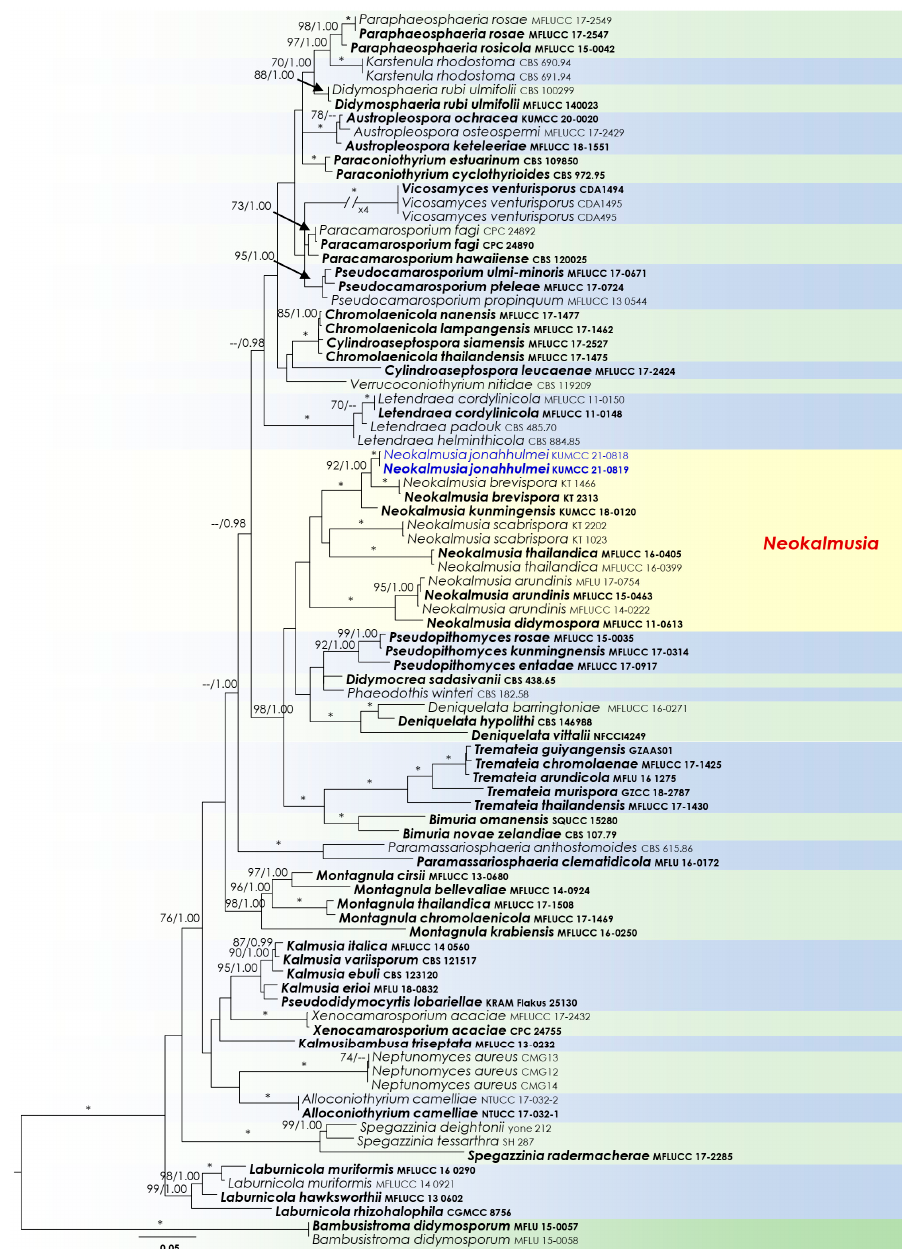
Figure 2. RAxML phylogram generated from combined dataset of partial SSU, LSU, ITS, tef 1, and rpb 2 DNA sequence analyses for Didymosphaeriaceae . The tree is rooted to Bambusistroma didymosporum (MFLU 15-0057, MFLU 15-0058). Bootstrap supports ML (MLB) ≥ 70% and Bayesian posterior probabilities (BYPP) ≥ 0.95 are given as MLB/BYPP above the branches. Branches with an asterisk (*) indicate MLB = 100% and BYPP = 1.00. The newly generated isolates are in